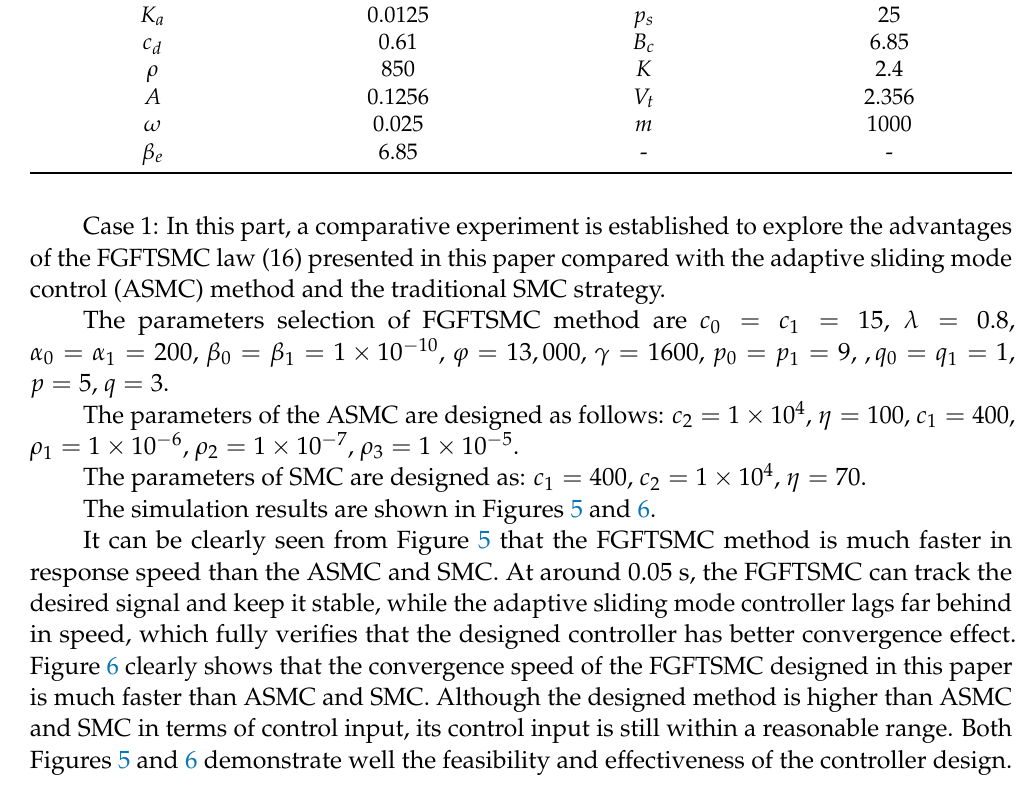
Table 1. Nominal values of hydraulic servo system parameters.